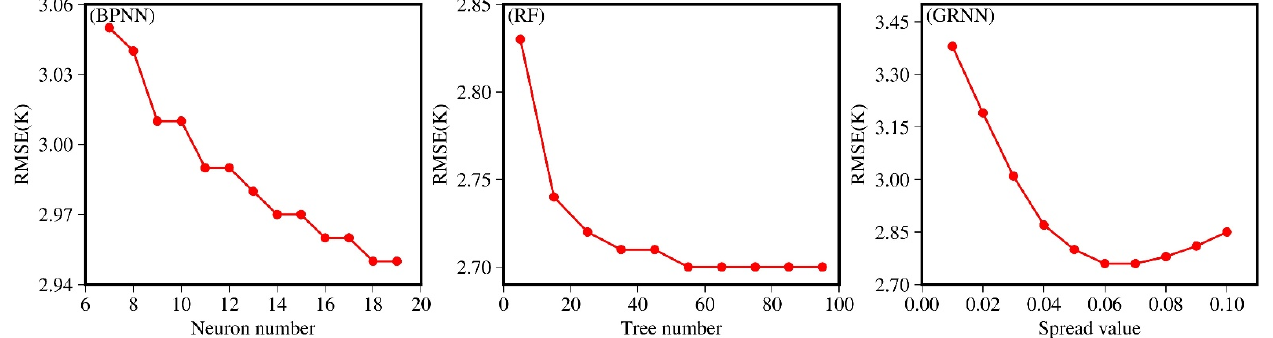
Figure 5. Statistical diagram of RMSE of different models with different parameter settings based on a 10-fold cross-validation technique.